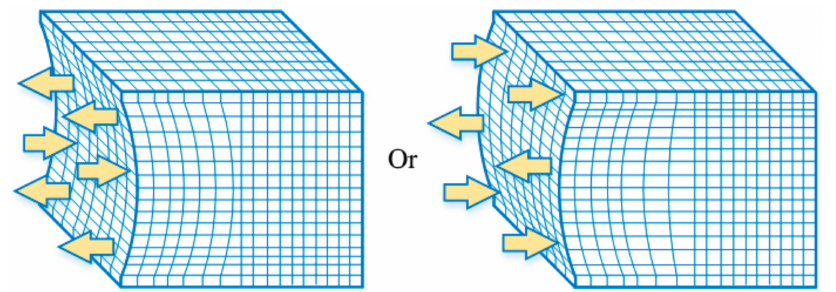
Figure 1. The principle of the contour